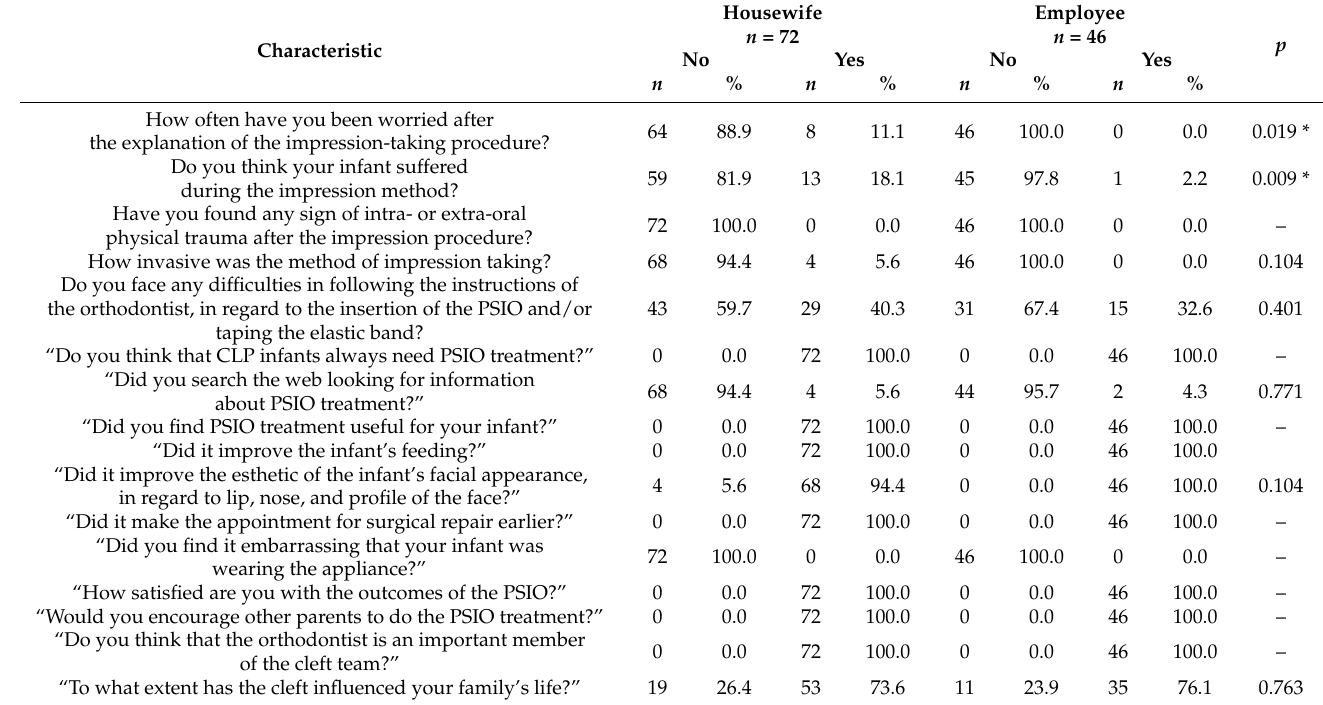
Table 4. Mother’s perception and experience related to PSIO in association with working